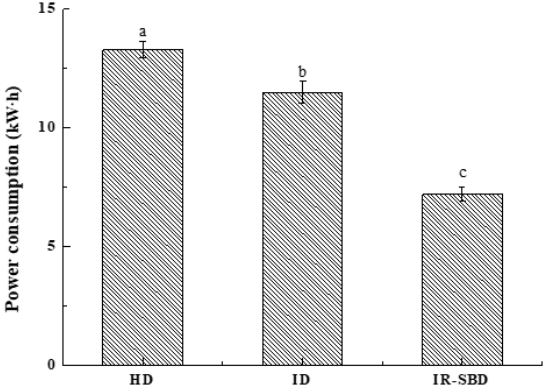
Figure 10. Power consumption of dried peanuts with shells by three drying methods. Different letters indicate significant differences ( p < 0.05).